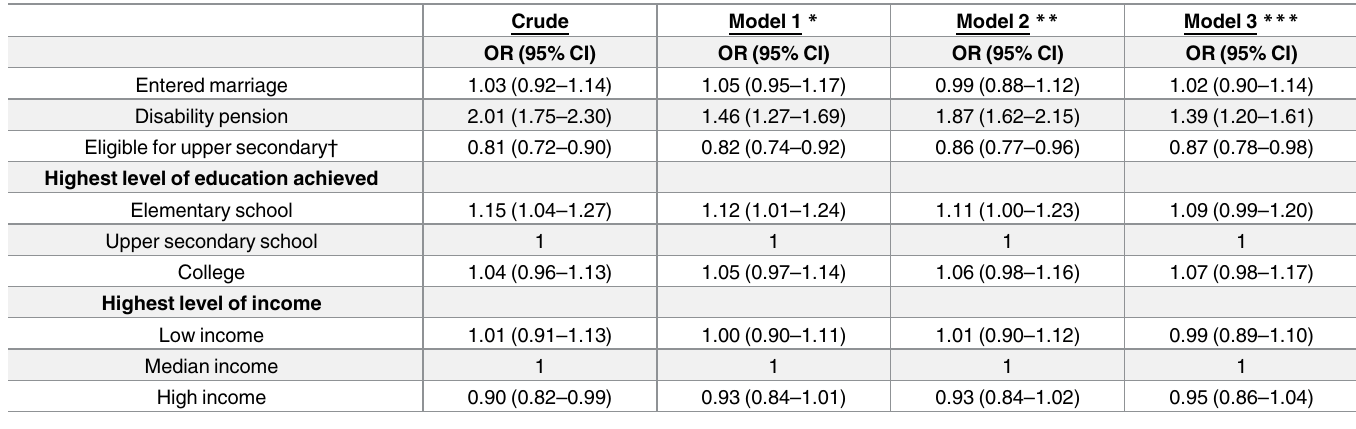
Table 2. Logistic regression models for the associations between hypospadias and socioeconomic outcomes, regardless of phenotype.